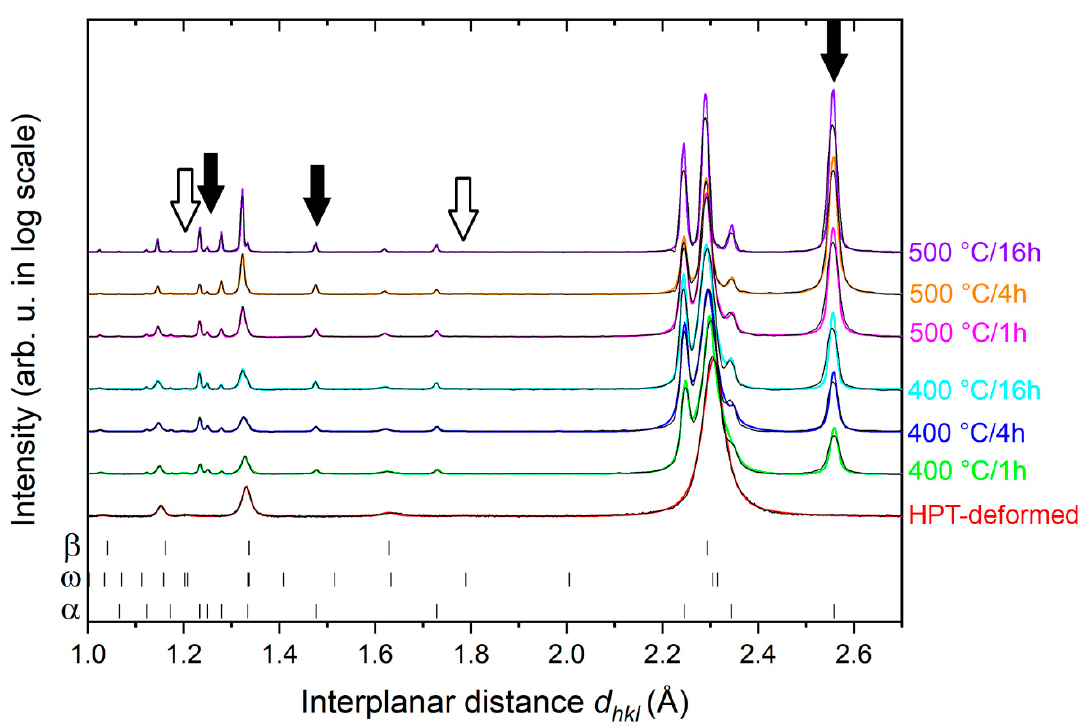
Figure 7. XRD patterns of aged conditions of the HPT-deformed Ti15Mo alloy: HPT-deformed without ageing (black curve) and aged under different conditions (colored curves) are displayed. The patterns are vertically shifted for clarity. The most important peaks are marked by full and open arrows for α and ω phase, respectively.